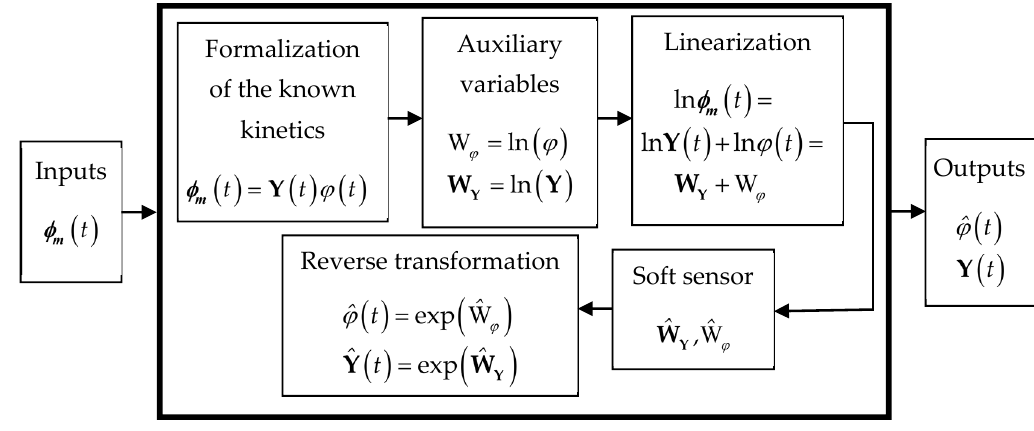
Figure 1. General structure of kinetics software sensor.